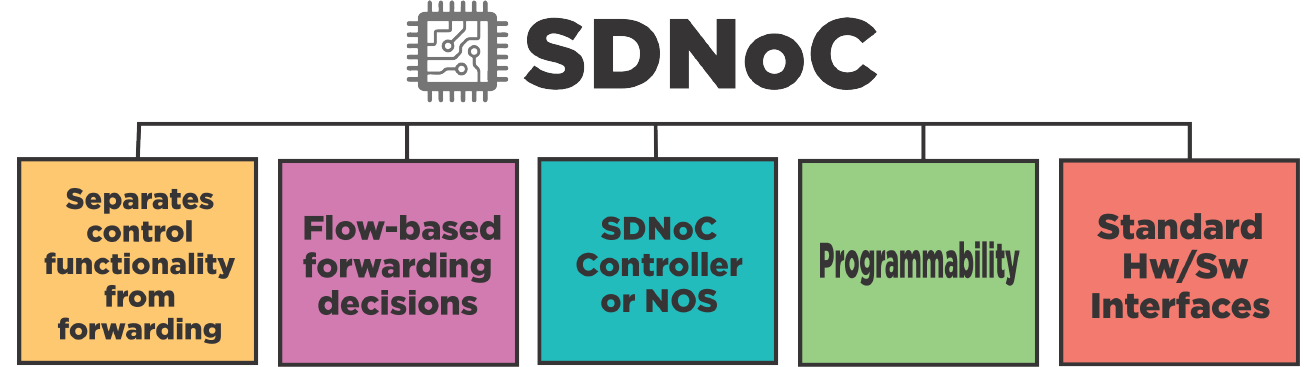
Figure 7. This graphic presents the NoC desired features adapted from SDN